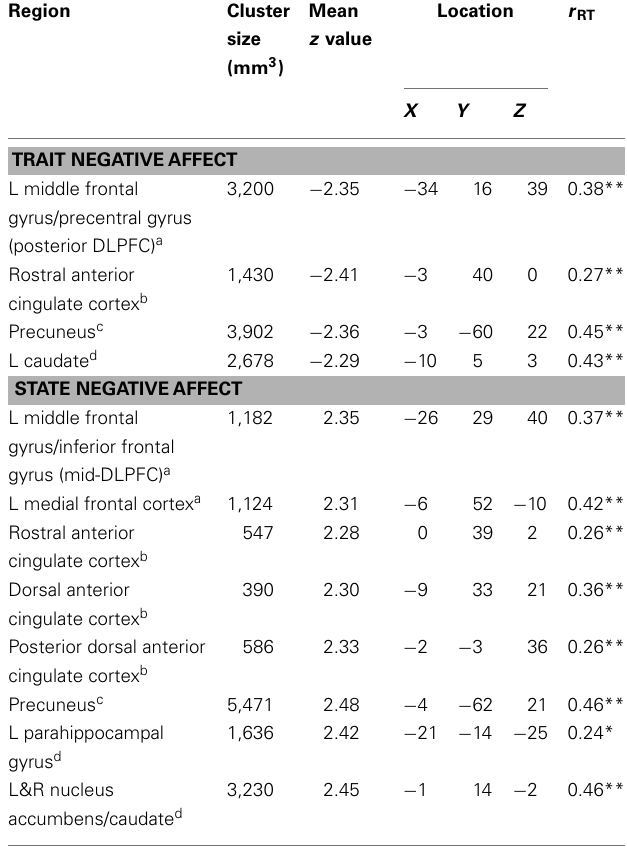
Figure 1 ). Three separate clusters emerged in the ACC: rACC, an anterior region of dorsal ACC (dACC), and posterior dACC. In addition to mid-DLPFC, a second cluster emerged using the frontal cortex mask, in left medial frontal cortex. Finally, when using the whole-brain gray-matter mask, two additional clusters emerged: one in left parahippocampal gyrus and one spanning left and right nucleus accumbens/caudate. There were no significant amygdala clusters. Further, there were no significant clusters neg- atively correlated with state NA. An examination of the